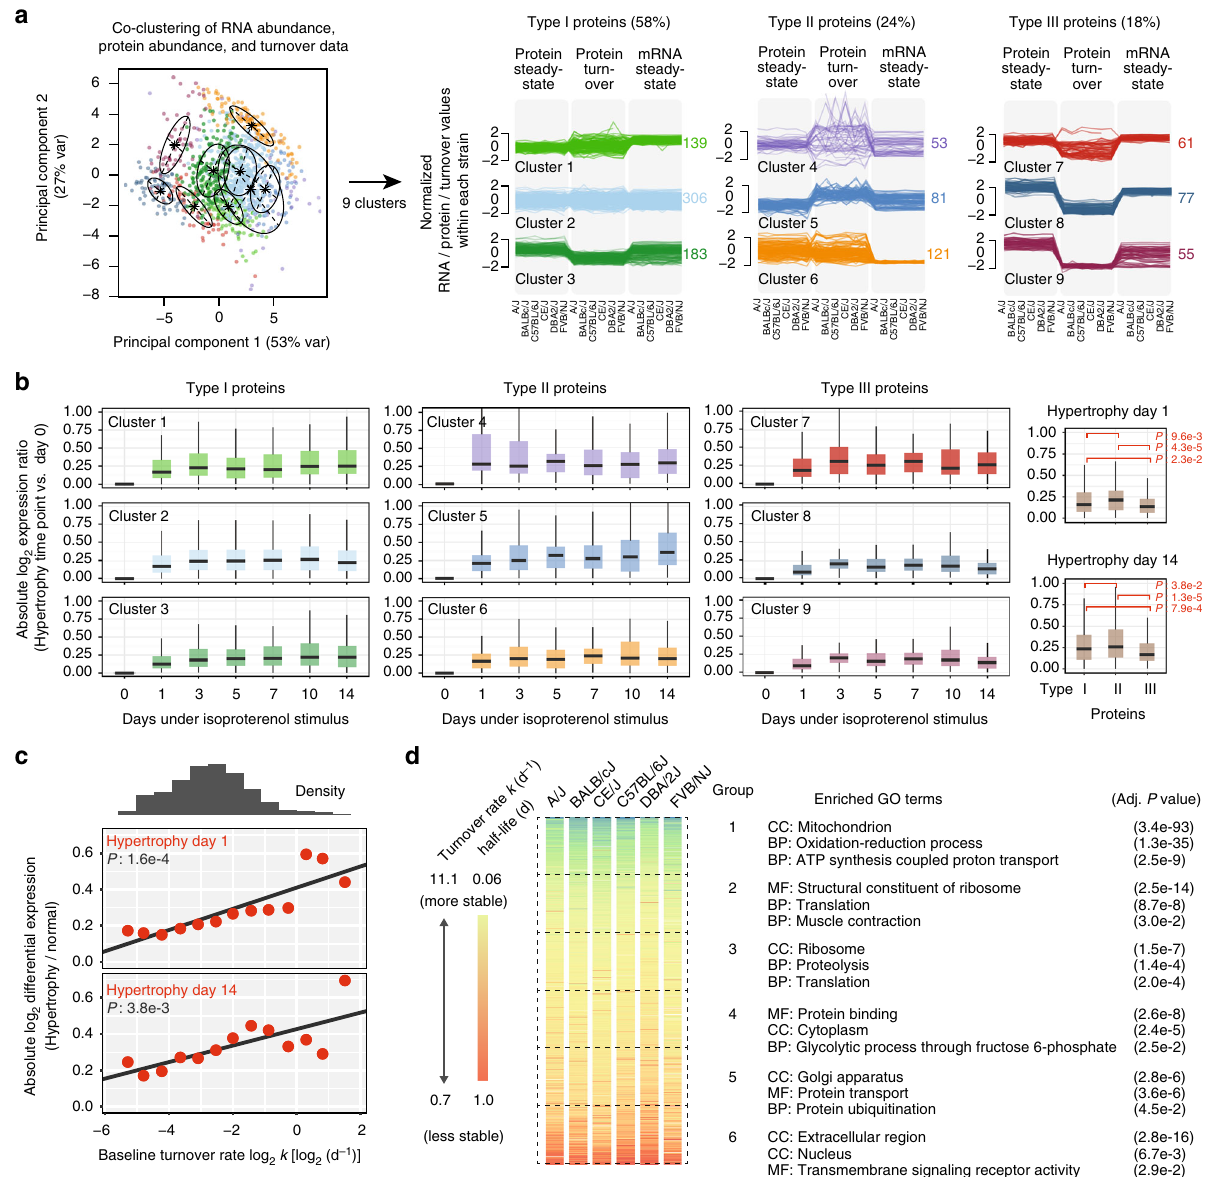
Fig. 4 Co-clustering of RNA, protein, and the abundance data reveals hierarchical protein response to cardiac hypertrophy. a Unsupervised clustering of the multi-omics data sets distinguishes genes into 9 clusters based on all three omics data types. First two principal components (PC) are shown; Ellipses demarcate the locations of clusters. Right: The 9 identi fi ed clusters of proteins are visualized separately with line charts showing standardized protein abundance, protein turnover, and transcript abundance in all strains. (Left) Type I protein clusters have relative protein abundance commensurate with relative protein turnover and transcript abundance. Type II proteins show relatively high turnover. Type III proteins have relatively high transcript and protein abundance but low turnover. Numbers: protein counts in clusters. b Boxplots of log ratios of protein abundance in hypertrophic vs. normal hearts ( y -axis) at multiple time points ( x -axis) from each cluster, showing their different responses to isoproterenol stimulation over 14 days. Type II proteins exhibit earlier and greater responses in protein abundance changes during hypertrophy compared to Type I proteins, whereas Type III proteins show suppressed response. The data suggest an organization pattern of protein turnover associated with the speed and magnitude of protein remodeling in the heart. Inset shows side-by-side comparisons of Type I, II, III proteins. Box: 25th to 75th percentile; whiskers: 5th to 95th percentile. c Higher baseline turnover rate ( x -axis) of a protein is associated with greater magnitude of differential expression under hypertrophy ( y -axis). P value: linear regression of absolute differential expression against baseline turnover rates in all proteins, with baseline relative abundance of a protein as covariate. d Heat map showing distributions of turnover rates of cardiac proteins quanti fi ed across mouse strains (green: slower turnover/longer half-life; red: faster turnover/ shorter half-life). Proteins are divided into six bins (Group 1 – 6) according to their average turnover. Each bin is signi fi cantly enriched in distinct Gene Ontology terms that re fl ect the organizational structure of the proteome. Housekeeping proteins tend to turn over slowly and regulatory proteins turn over